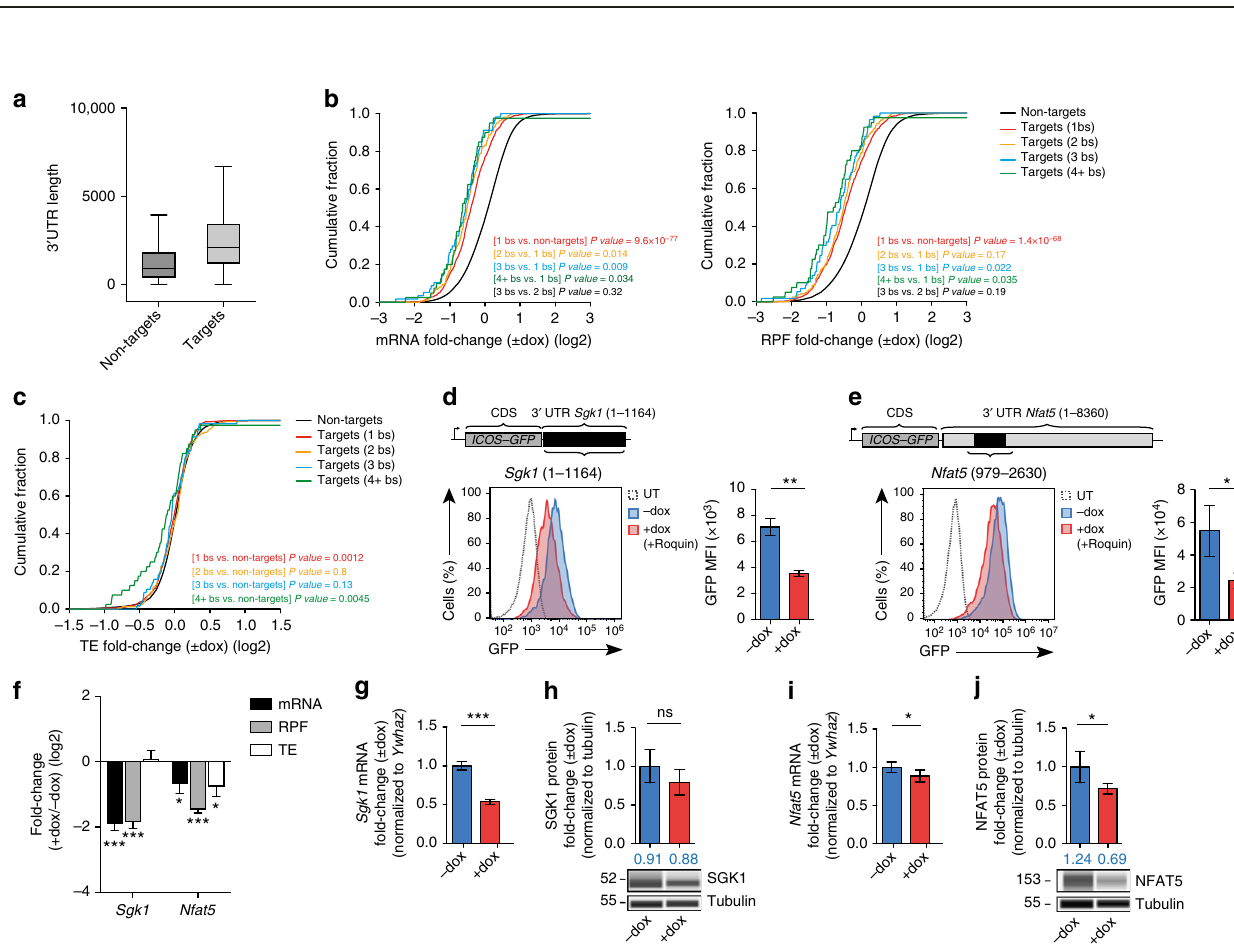
Fig. 8 Roquin regulates translation of targets with four or more binding sites. a Distribution of 3 ′ -UTR lengths for Roquin-bound targets and nontargets. Boxes extend from the 25th to 75th percentiles (interquartile range (IQR)), horizontal lines represent the median, whiskers indicate the lowest and highest datum within 1.5*IQR from the lower and upper quartiles, respectively. b , c Cumulative distributions of mRNA and RPF ( b ), or TE ( c ) fold-change between Roquin-1 overexpressing ( + dox) and Rc3h1 – 2 − / − ( − dox) MEF cells. PAR-CLIP-identi fi ed targets were split based on the number of Roquin-binding sites that they contained (different colors). The comparison between the subsets of targets was performed with the Mann – Whitney U test and the P values for the two-tailed test are indicated. bs, binding site. Targets with 1 bs ( n = 697), 2 bs ( n = 161), 3 bs ( n = 157) and 4 + bs ( n = 40). Nontargets ( n = 9322). ( d , e ) Reporter assays testing the full-length 3 ′ -UTR of Sgk1 ( c ) as well as one individual part from the long 3 ′ - UTR of Nfat5 (979-2630) ( d ) by fl ow cytometry showing untransduced Rc3h1 – 2 − / − MEF cells (dashed line) and transduced cells with (red line) or without (blue line) doxycycline-inducible expression of Roquin-1. MEF cells were treated with doxycycline for 14 h. MFI was calculated for GFP. ( f ) mRNA, RPF and TE fold-changes for the Roquin targets Sgk1 and Nfat5 in Roquin-1 overexpressing ( + dox) compared to Rc3h1 – 2 − / − ( − dox) MEF cells. ( g , i ) qPCR analysis of Sgk1 ( g ) and Nfat5 ( i ) gene expression in Rc3h1 – 2 − / − MEF cells treated with ( + dox) or without ( − dox) doxycycline for 14 h to induce Roquin-1 expression. ( h , j ) Automated capillary electrophoresis western analysis of SGK1 ( h ) and NFAT5 ( j ) in extracts of Rc3h1 − 2 − / − MEF cells treated with ( + dox) or without ( − dox) doxycycline for 14 h. Statistical signi fi cance was calculated by unpaired two-tailed Student ’ s t test ( d , e , g – j ) and Wald test ( f ); ns = not signi fi cant; * p < 0.05, ** p < 0.01, *** p < 0.001. Error bars indicate mean ± SD ( d , e , g – j ) or ±SEM ( f ). Data are representative of 13 ( a – c , f ) and four ( d , e , g – j ) independent experiments